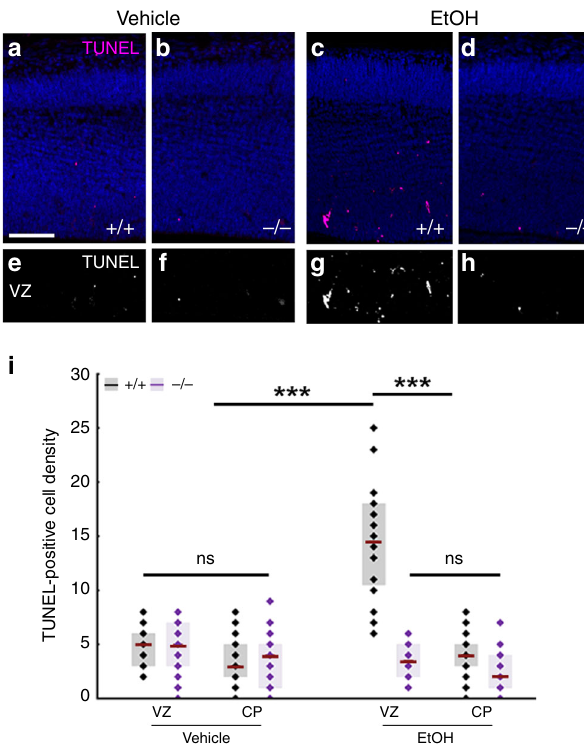
Fig. 7 ABHD4 is necessary for cell death caused by fetal alcohol exposure. Compared to vehicle-treated mice ( a , b , e , f ), increased number of TUNEL-positive dead cells is seen in ethanol-treated wild-type ( + / + ), ( c , g ), but not in Abhd4- knockout ( − / − ) mice ( d , h ) in the ventricular (VZ) zones of embryos derived from dams undergoing subchronic alcohol Fig. 8 Mechanism of ABHD4-dependent developmental anoikis. a , b treatment, but not in the cortical plate (CP). i Quanti fi cation of the density Schematic drawing illustrates the distinct ABHD4-dependent fate of of TUNEL-positive cells in the VZ and in the CP after subchronic ethanol- normally delaminated and abnormally detached cells in the developing treatment (Kruskal – Wallis test with post hoc Dunn ’ s test, *** P < 0.0001; ns cerebral cortex. After cell division, healthy daughter cells downregulate = not signi fi cant, P ≈ 1, n = 31 sections from n = 5 animals per wild-type, ABHD4, delaminate from the ventricular wall and migrate into the cortical vehicle-treated mice, n = 27 sections from n = 4 animals per Abhd4- plate along the radial processes of RGPCs. Random developmental errors knockout, vehicle-treated mice, n = 24 sections from n = 4 animals per and pathological insults such as fetal alcohol exposure often destroy the wild-type, ethanol-treated mice, n = 18 sections from n = 3 animals per adherens junctions and trigger pathological detachment. As a central Abhd4- knockout, ethanol-treated mice). Graphs show box-and-whisker mediator of developmental anoikis, ABHD4 is necessary and suf fi cient to plots (including minima, maxima, and median values, lower and upper induce cell death that prevents the accumulation of misplaced progenitor quartiles) with single values. Scale bars: a – h : 100 μ m. Source data are cells at ectopic locations. CP cortical plate, SVZ subventricular zone, VZ provided as a Source Data fi le. ventricular zone. NATURE COMMUNICATIONS| (2020) 11:4363